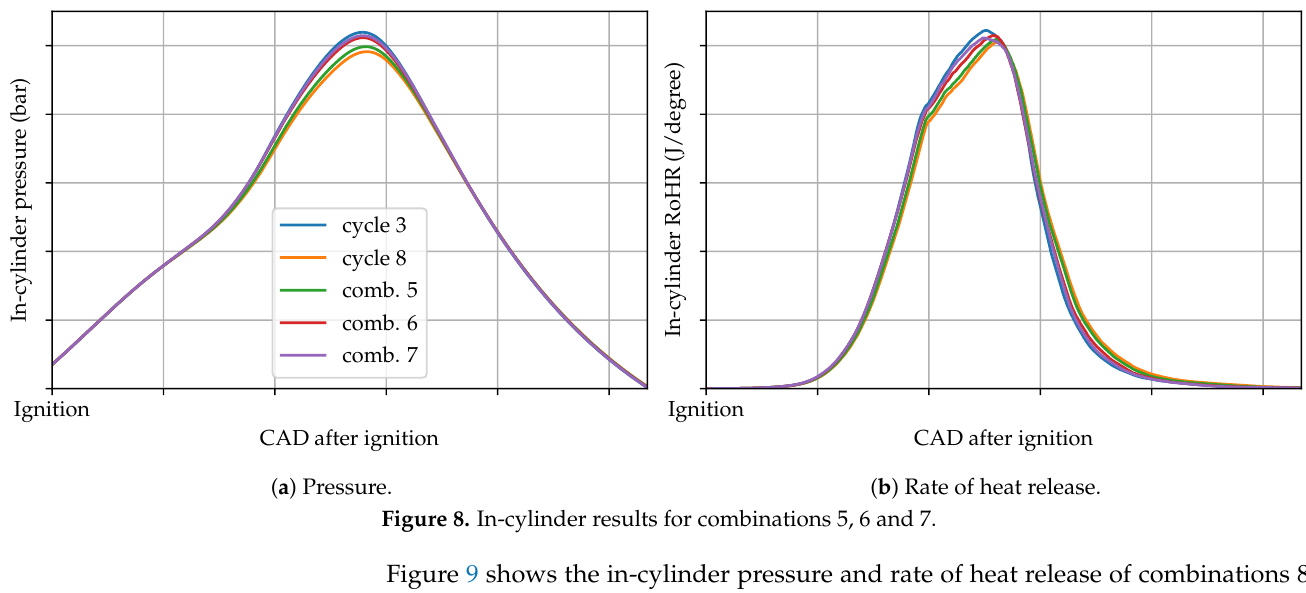
Figure 8. In-cylinder results for combinations 5, 6 and 7. Figure 9 shows the in-cylinder pressure and rate of heat release of combinations 8, 9 and 10, which are similar to combinations 6, 7 and 8, respectively; however, the time of the snapshot is shifted closer to spark timing from 5 CAD to 0.5 CAD before ignition. The impact of this shift is most pronounced on the results using a 1 cm sphere extraction volume. In this case the in-cylinder peak pressure increased from 25.9% to 48.7%. The other two combinations only show a minor change in peak pressure, where combination 9 has almost the same peak pressure as combination 6 (72.0% vs. 72.1%) and combination 10 even shows a significantly lower peak pressure than combination 7 (82.7% vs. 77.1%). This implies that the flow field between the 2 cm and 5 cm spheres only plays a minor role